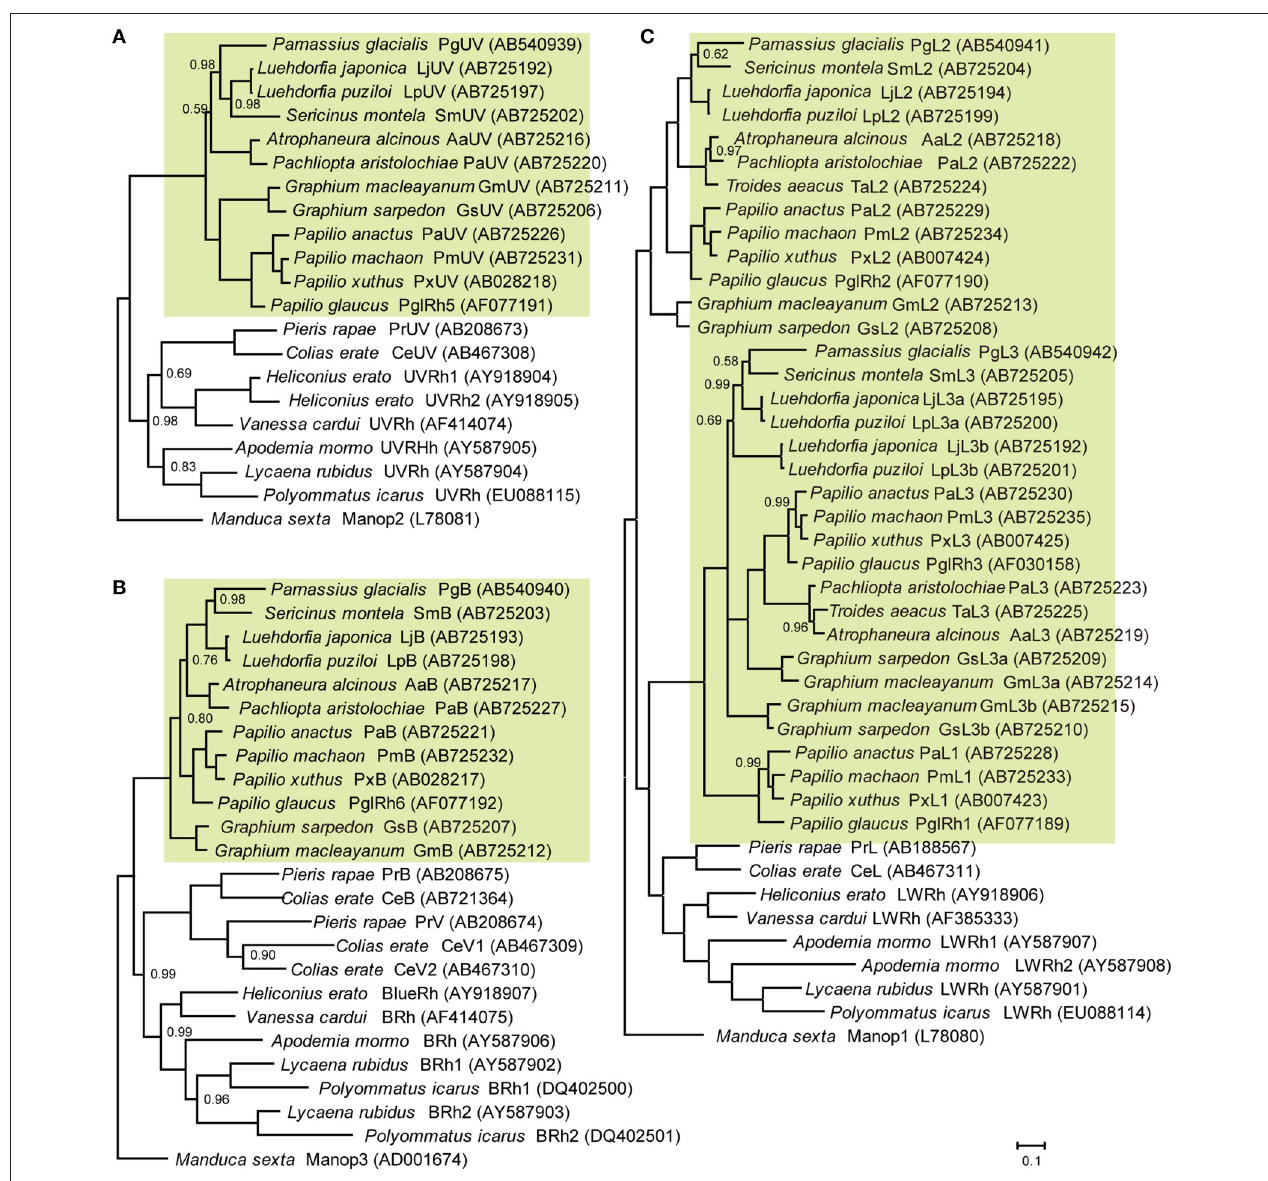
FIGURE 2 | Phylogeny of butterfly visual pigment opsins constructed according to Bayesian inference methods (BI). Green background indicates opsins of papilionid species. Numbers at the nodes represent probabilities based on 500,000 replicate analyses; where omitted, the probability is 1.00. (A) Ultraviolet-absorbing type. (B) Blue-absorbing type. (C) Long wavelength-absorbing type. Data accession numbers are shown on the right side of opsins in parentheses.